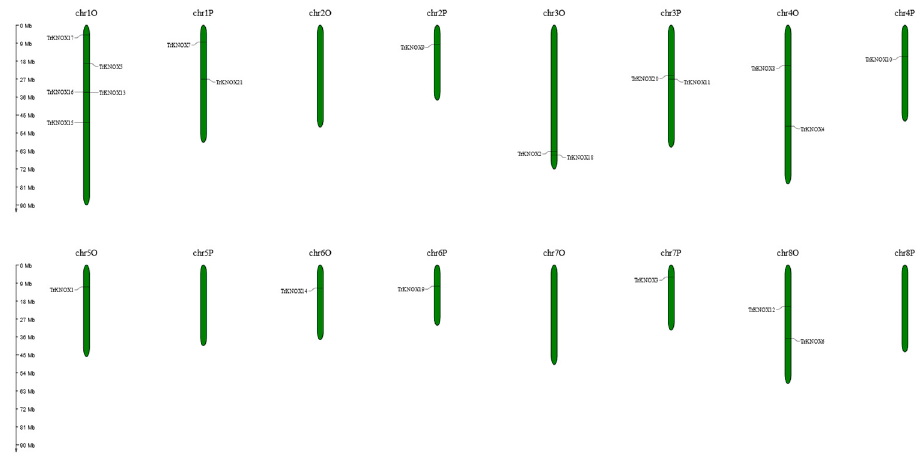
Figure 4. Phylogenetic relationships and motif compositions of KNOX family proteins of four re- lated species. The tree divided the TrKNOX proteins into three subgroups, Class I, Class II, and Class M.